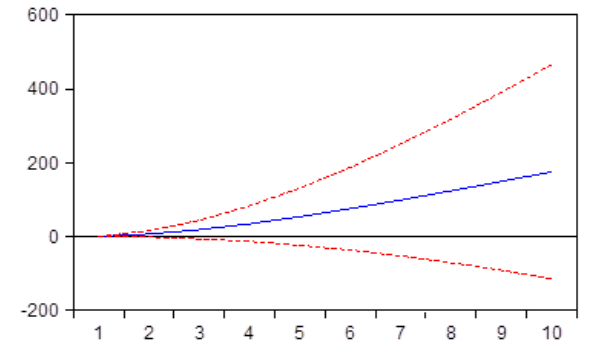
Figure 4. Impact of payments made by households for healthcare, expressed as euro per inhabitants on knowledge-intensive activities.